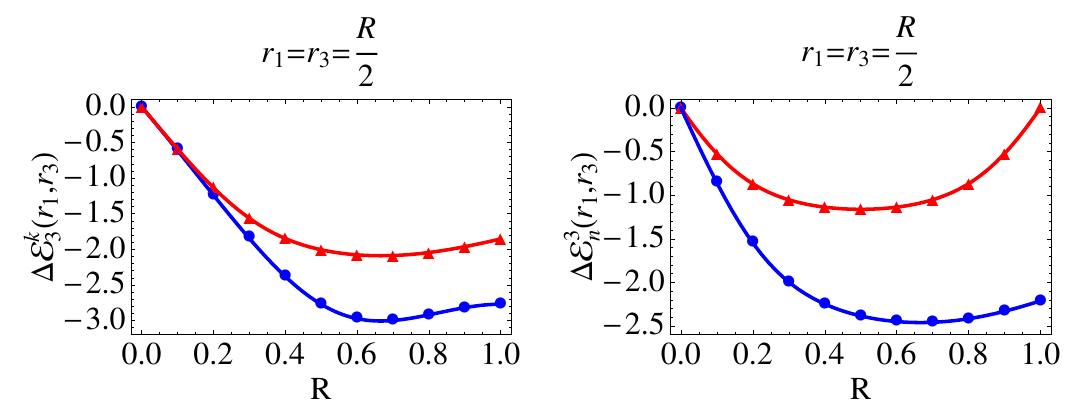
Figure 9 . Left: n (cid:16) 3 for a state of two equal particles k (cid:16) 2 with p (cid:16) 4 (cid:25) (triangles) and for a state of two distinct particles with momenta p 1 (cid:16) 3 (cid:25) and p 2 (cid:16) 4 (cid:25) (circles). The solid lines are the analytic formulae for (cid:1) E 2 p r 1 ; r 2 q (for equal momenta) and 2(cid:1) E 1 p r 1 ; r 2 q for distinct momenta. 3 3 Right: k (cid:16) 3 and n (cid:16) 2 (triangles), n (cid:16) 3 (circles) for a state of three identical excitations with momenta p (cid:16) 4 (cid:25) . Solid lines are the analytic formulae (2.6).